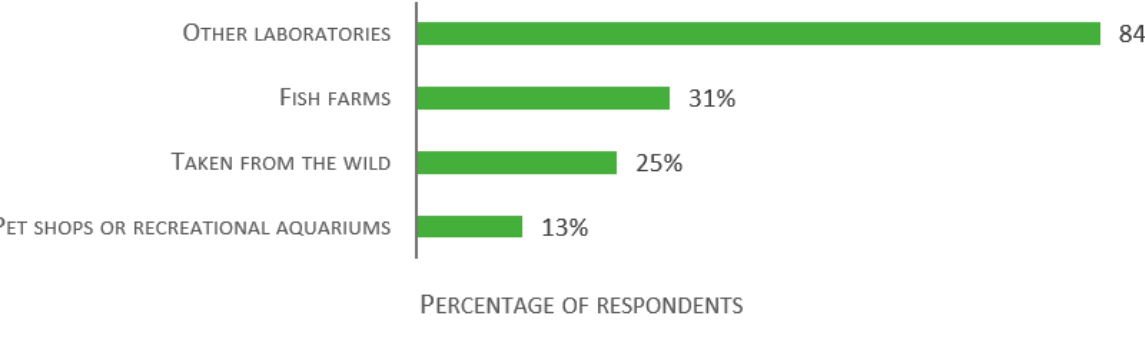
Figure 11. Responses to the multiple-choice question: “Please select the origin of the fish used in your research establishment.”, presented as percentage of respondents ( n = 138). Each respondent was allowed to select multiple answers.